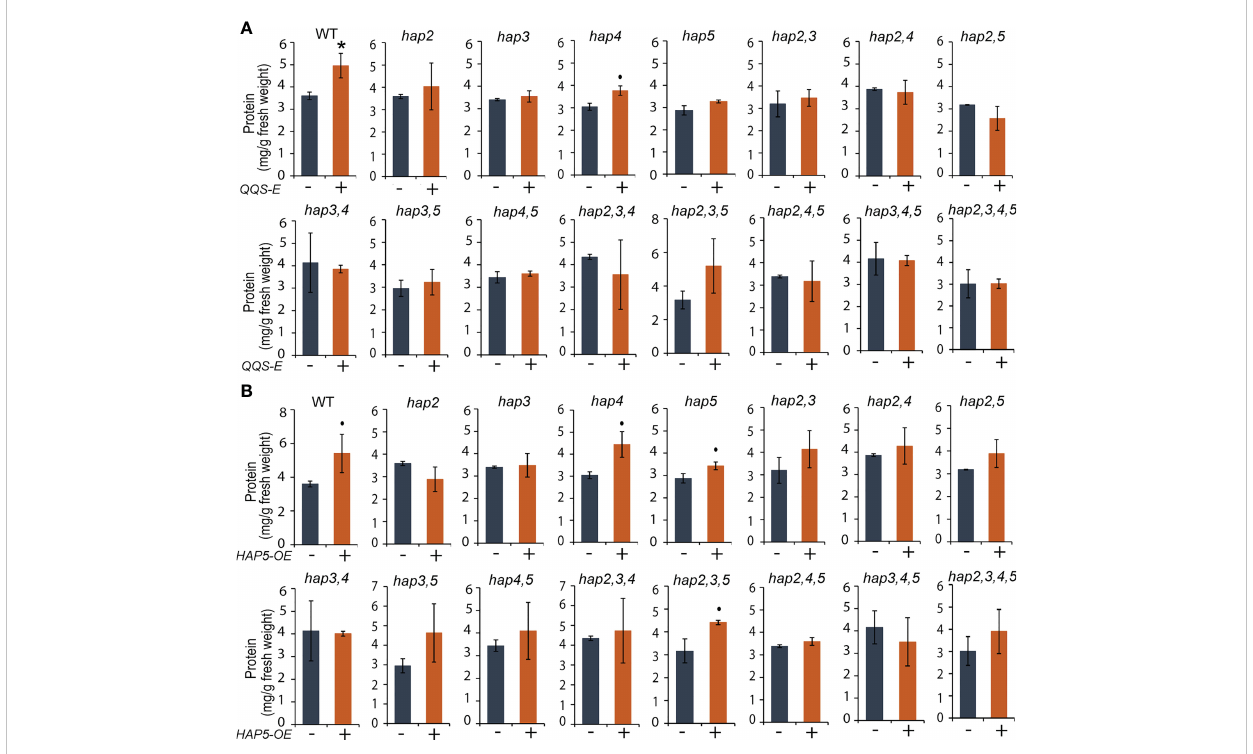
FIGURE 5 The effect of transgenic QQS-E and HAP5-OE on the protein content of yeast hap mutant strains. (A) QQS-E . (B) HAP5-OE . All data are mean ± SE, n = 3. Statistical signi fi cance relative to the strains without QQS-E or without HAP5-OE was calculated with Student ’ s t -test and is indicated: * P < 0.05, (cid:129) P <